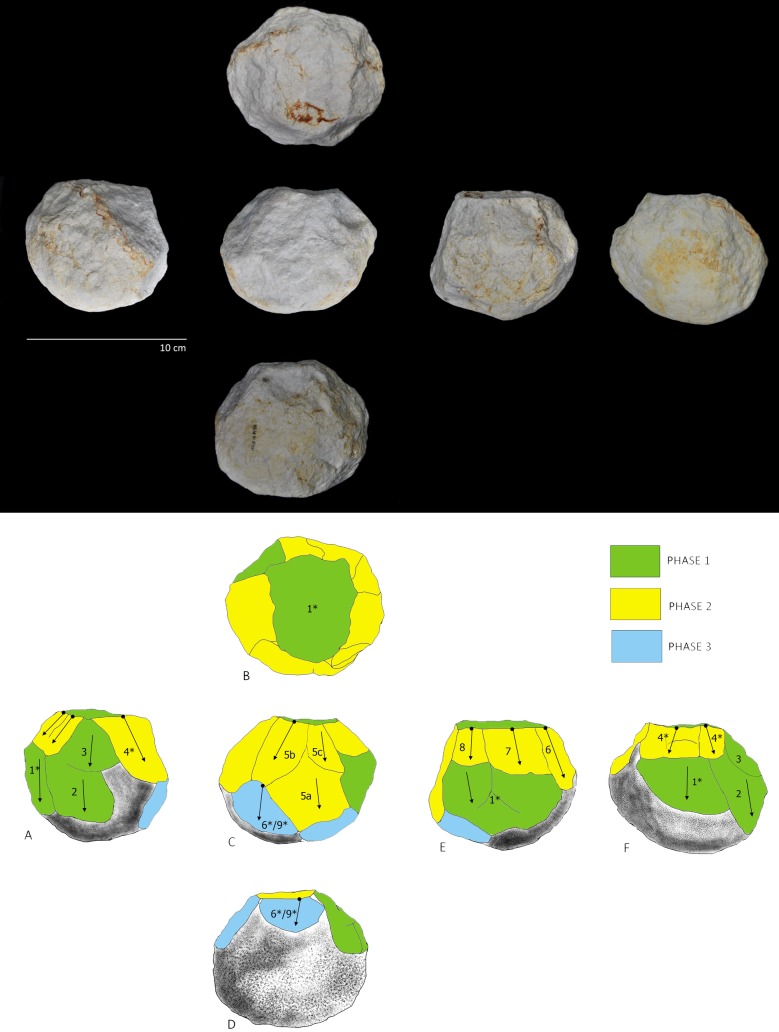
Photo and diacritic drawing of Tool E.Phase 1 (in green): Creation of a platform (Profile B) by a removal or a previous phase of partial peripheral management of the tool (Profile E and F, green); Phase 2: (yellow). A series of peripheral extractions 4 *, 5a, 5b, 5c, 6, 7, 8 (Profiles A, C, E and F) from percussion platform created by negative 1* (Profile B) partially effaces the Phase 1 negatives. Phase 3 (blue), oblique removals contribute to lending a rounded morphology to the tool (Profiles C and D).